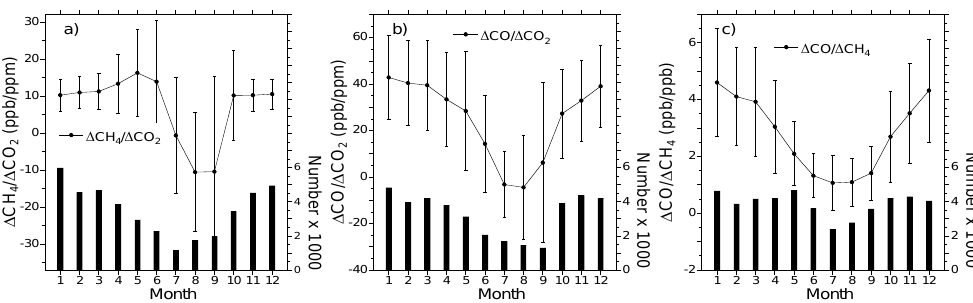
Fig. 4. Average seasonal variation of (a) 1 CH 4 / 1 CO 2 , (b) 1 CO/ 1 CO 2 , and (c) 1 CO/ 1 CH 4 slopes observed at HAT. The error bars represent the standard deviations from the monthly averages. The vertical bars represent the data